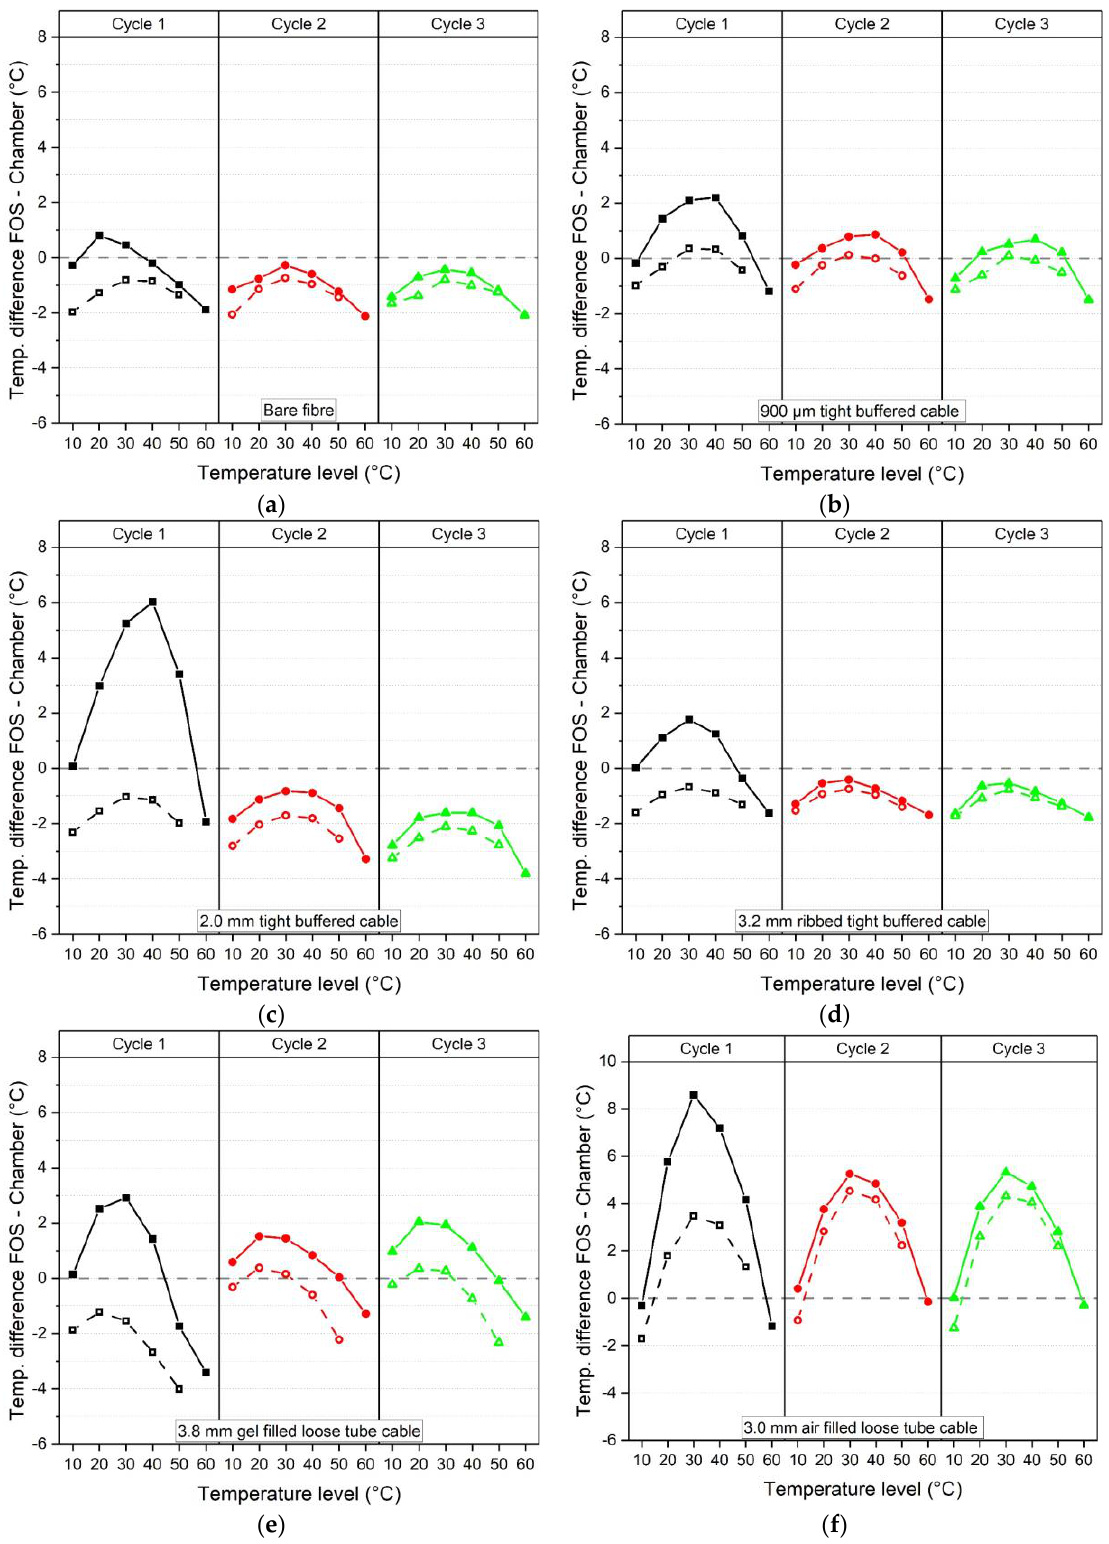
Figure 17. Temperature difference between fibre optic cable and chamber temperature evaluated at each temperature level. Solid lines represent increasing, dashed lines decreasing cycles, ( a ) bare fibre, ( b ) 900 μm tight buffered, ( c ) 2.0 mm tight buffered, ( d ) 3.2 mm ribbed tight buffered, ( e ) 3.8 mm gel filled loose tube and ( f ) 3.0 mm air filled loose tube cable. Table 8. Analysis of humidity and temperature deviation from the chamber reading.